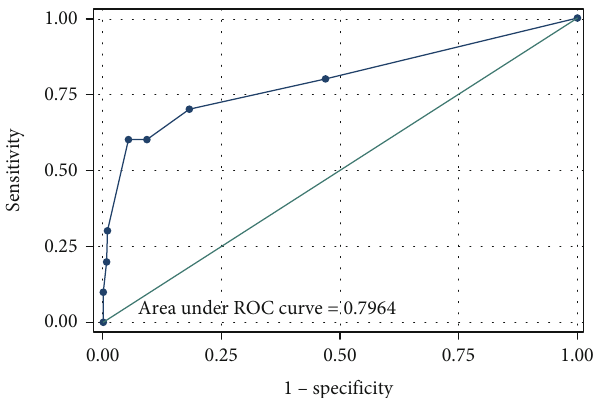
Figure 7: ROC curve testing our multivariate model. The area under the ROC curve was close to 1, con fi rming the quality of the model. The ROC analysis is used here to quantify how accurately our medical diagnostic test (bacterial pneumonia CRP > 130 mg/ L) can discriminate between poor and good outcomes in children hospitalized for